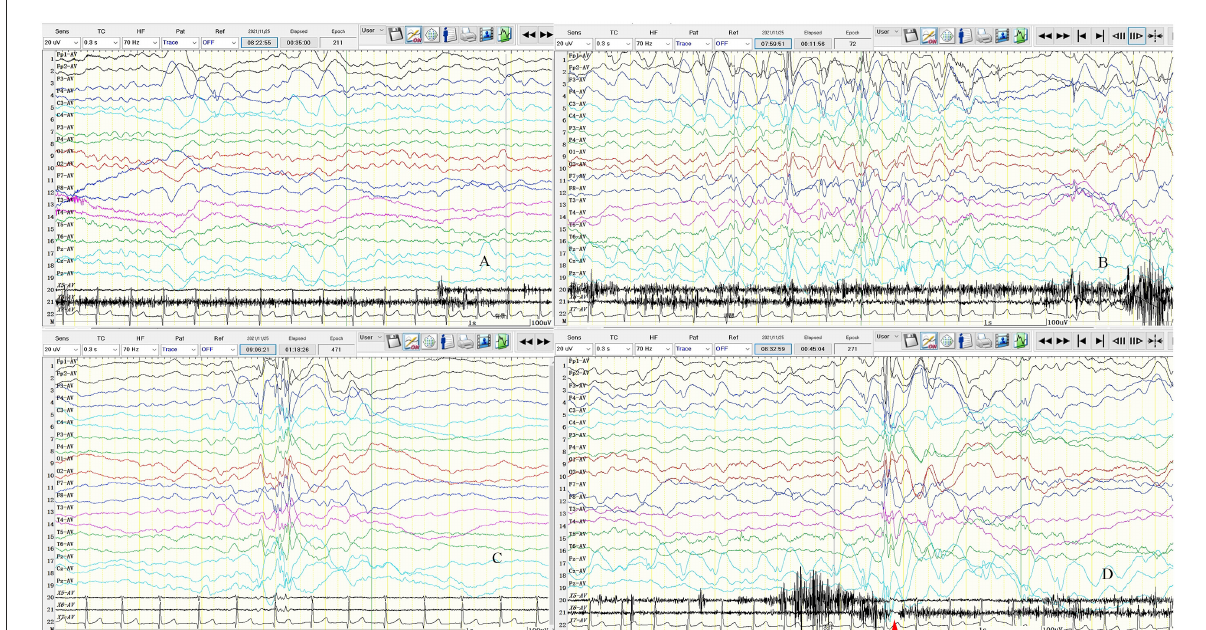
FIGURE2 Seven-hour (7-h) video-encephalography (VEEG) on admission. (A) Background activity slowed down, mainly with theta ( θ ) wave. (B) The left frontal pole, frontal, central, midfrontal line, and central region of the spike-slow wave discharged. (C) Multiply spike-slow wave; multispike-slow wave; the slow wave is covered with spine and spikes, cluster or rhythmic discharge in both hemispheres. (D) Atonic seizures. The transient electrical rest appeared 20–40ms in electromyography (EMG) after electroencephalogram (EEG) synchronous spike-slow wave burst. The clinical manifestations are head droop. X5: left upper limb; X6: left upper limb; X7: ECG; SEN: 20 uV; HF: 70; TC: 0.3; the red arrow is the electric